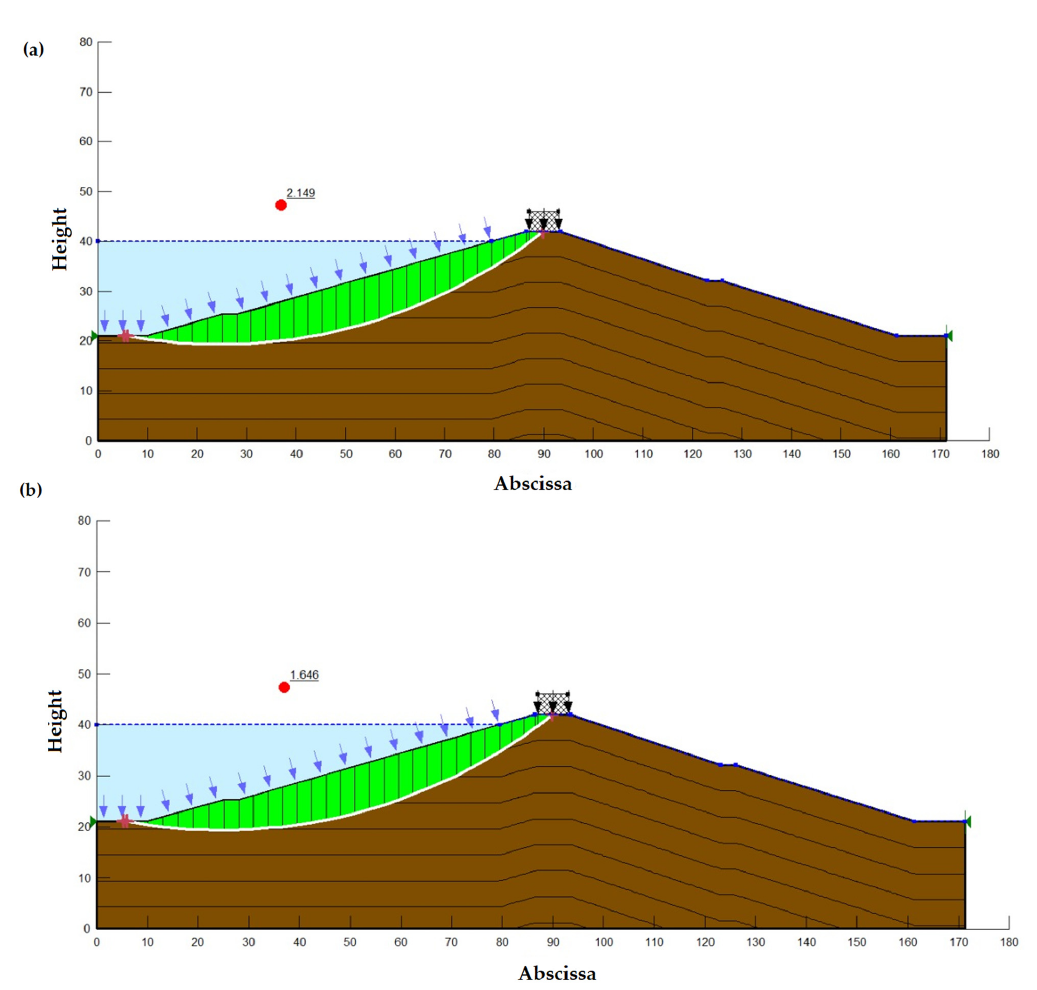
Figure 13. The safety factor of the upstream slope. ( a ) Slope stabilization with applied loads. ( b ) Slope stabilization with seismic analysis.